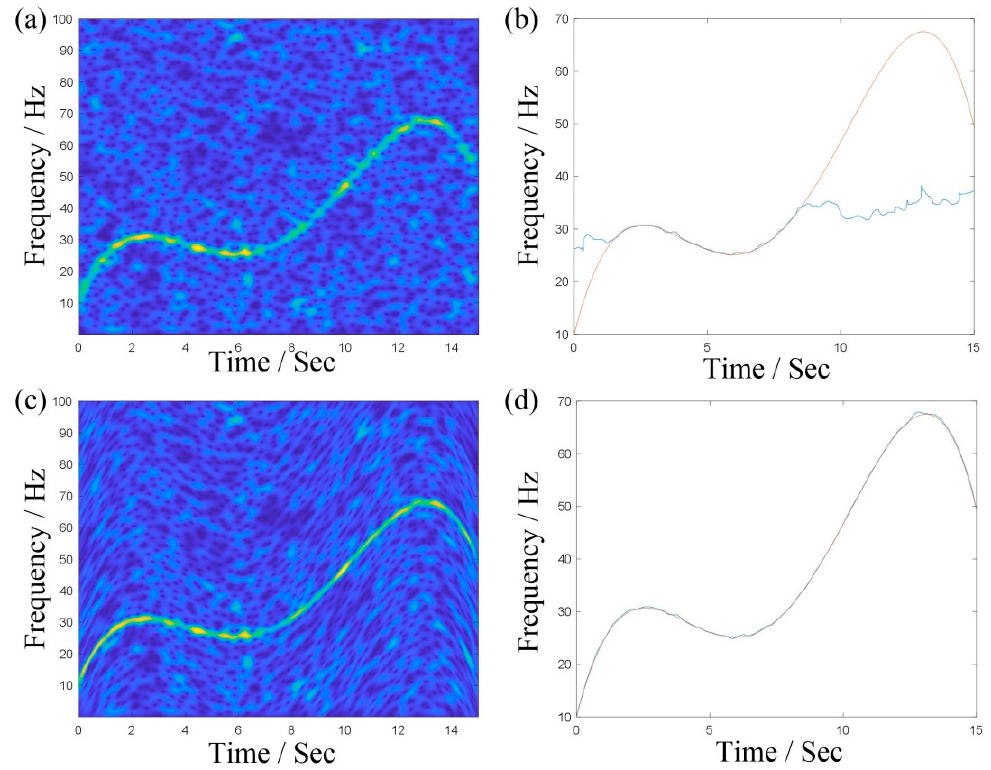
Figure 1. ( a , b ) are the TFR and extracted instantaneous frequency (IF) obtained using short-time Fourier transform (STFT); ( c , d ) are the TFR and extracted IF obtained using time-varying demodulation and the STFT (TDSTFT).